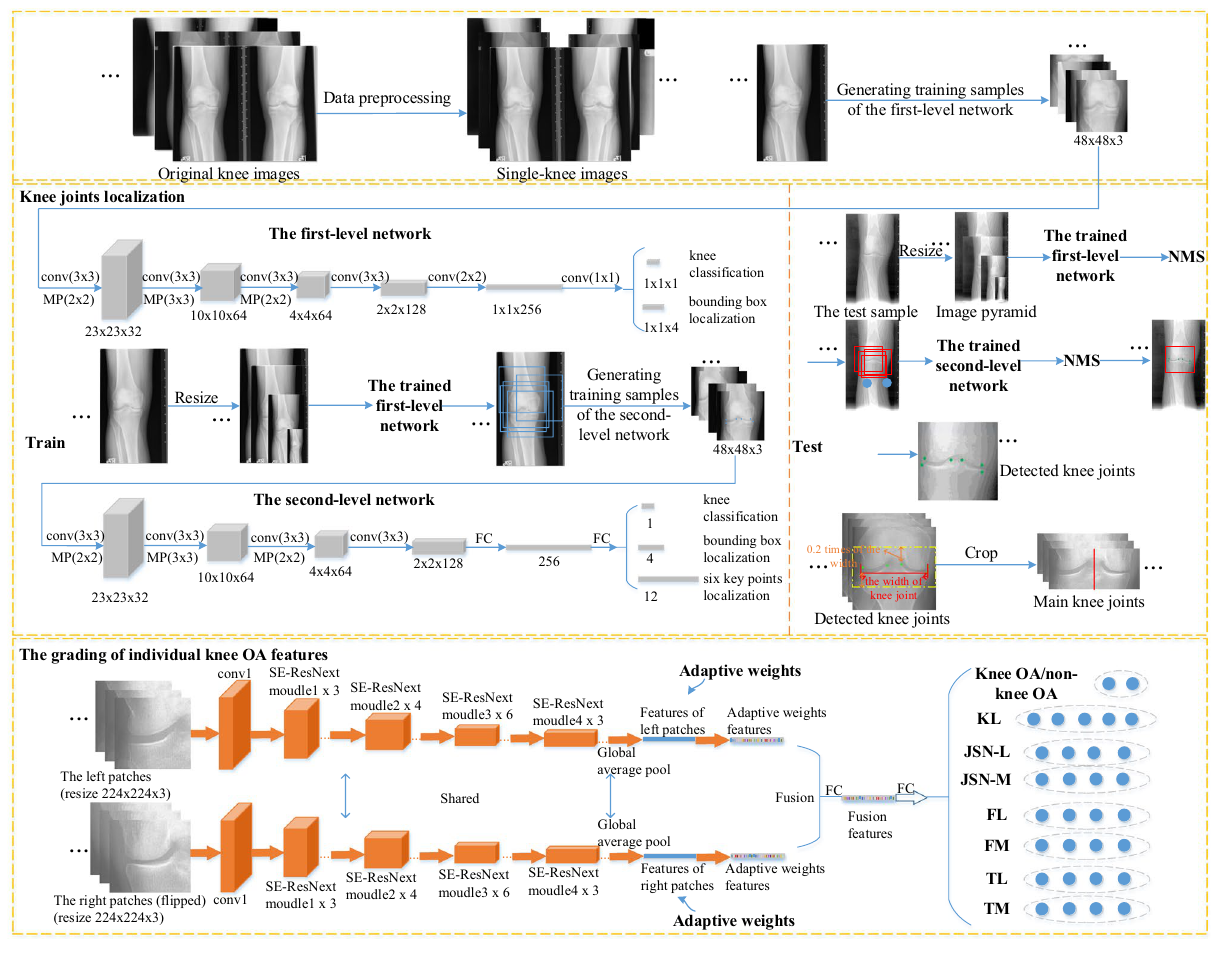
Figure 2. The whole process of the proposed